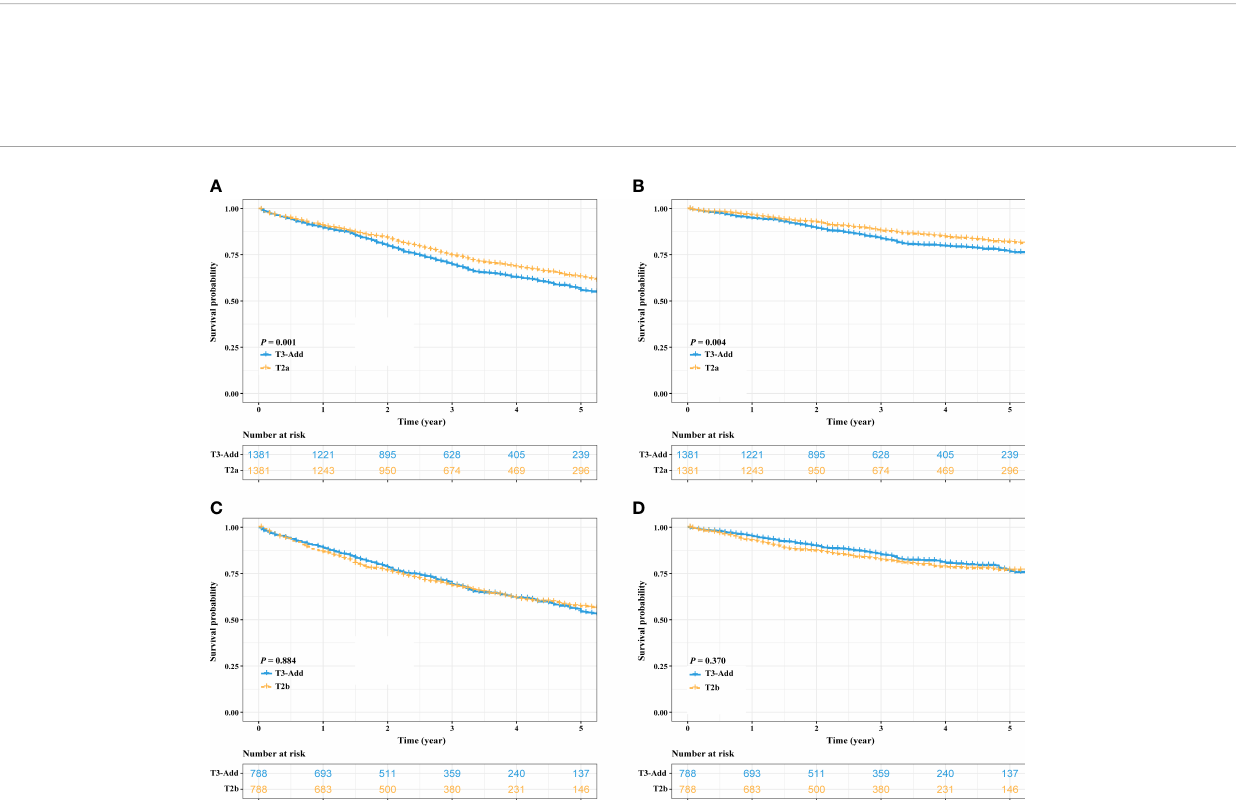
FIGURE 4 Kaplan – Meier estimates of survivals in the T3-Add & T2a pair and the T3-Add & T2b pair after PSM. (A) overall survival: T3-Add vs. T2a; (B) cancer speci fi c survival: T3-Add vs. T2a; (C) overall survival: T3-Add vs. T2b; (D) cancer speci fi c survival: T3-Add vs. T2b. PSM, propensity score matching; T3-Add, T3 non-small cell lung cancer with additional tumor nodules in the same